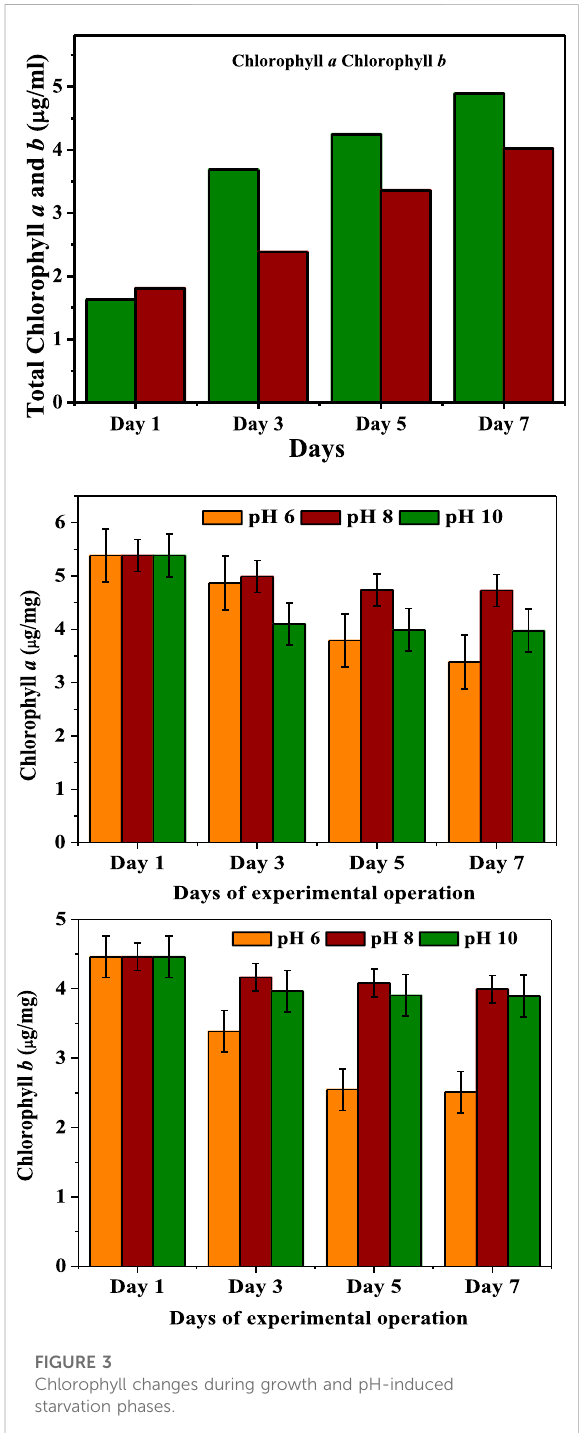
FIGURE 3 Chlorophyll changes during growth and pH-induced starvation phases.